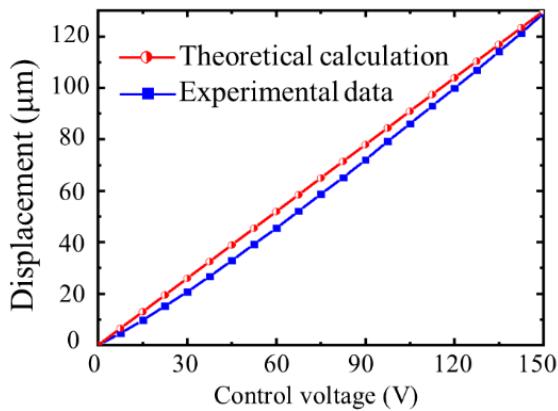
Figure 9. Maximum displacement of the actuator. A trapezoidal voltage signal with a slope of 360 V/s and a peak voltage of 120 V was applied to the PZT stack. The displacement curve of the driver is depicted in Figure 10. The driving stroke of the actuator is 103.23 µ m, and the non-driven displacement is 5.58 µ m. It is obvious from the figure that the non-driven displacement fluctuates greatly during the periods of voltage rise and fall because the symmetry of the bridge mechanism cannot be completely guaranteed under the actual machining conditions, making the output of the PZT stack different.